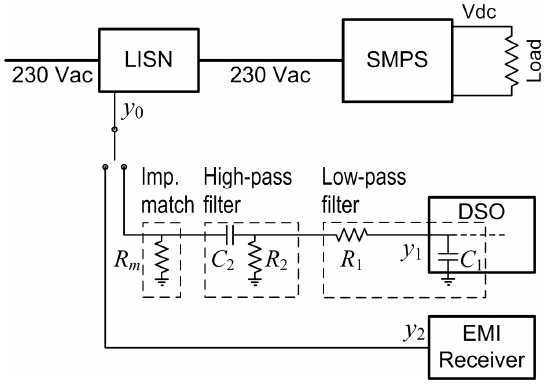
Figure 1. Scheme of the experimental setup: SMPS under test and its DC variable load, LISN (line impedance stabilization network), 50 Ω impedance matching, high-pass filter (1 kHz cutoff) and low-pass filter (2 MHz cutoff), digital storage oscilloscope (DSO) and EMI receiver.